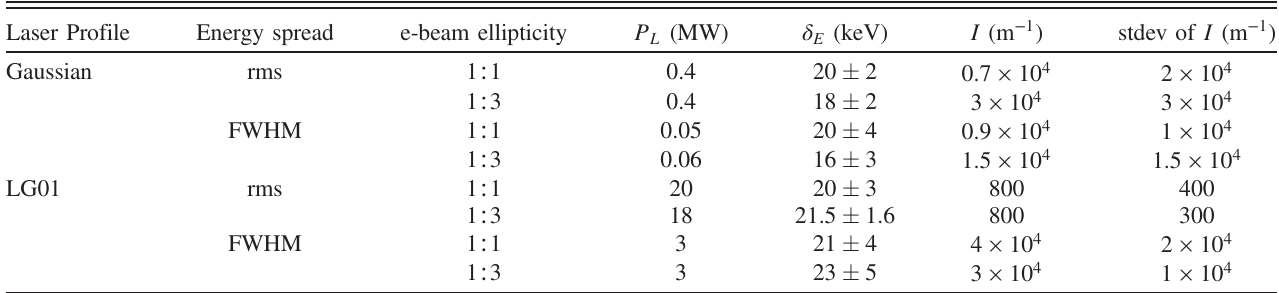
TABLE II. Energy spread and I values for Gaussian and LG01 intensity distributions for both rms and FWHM optimization. Laser